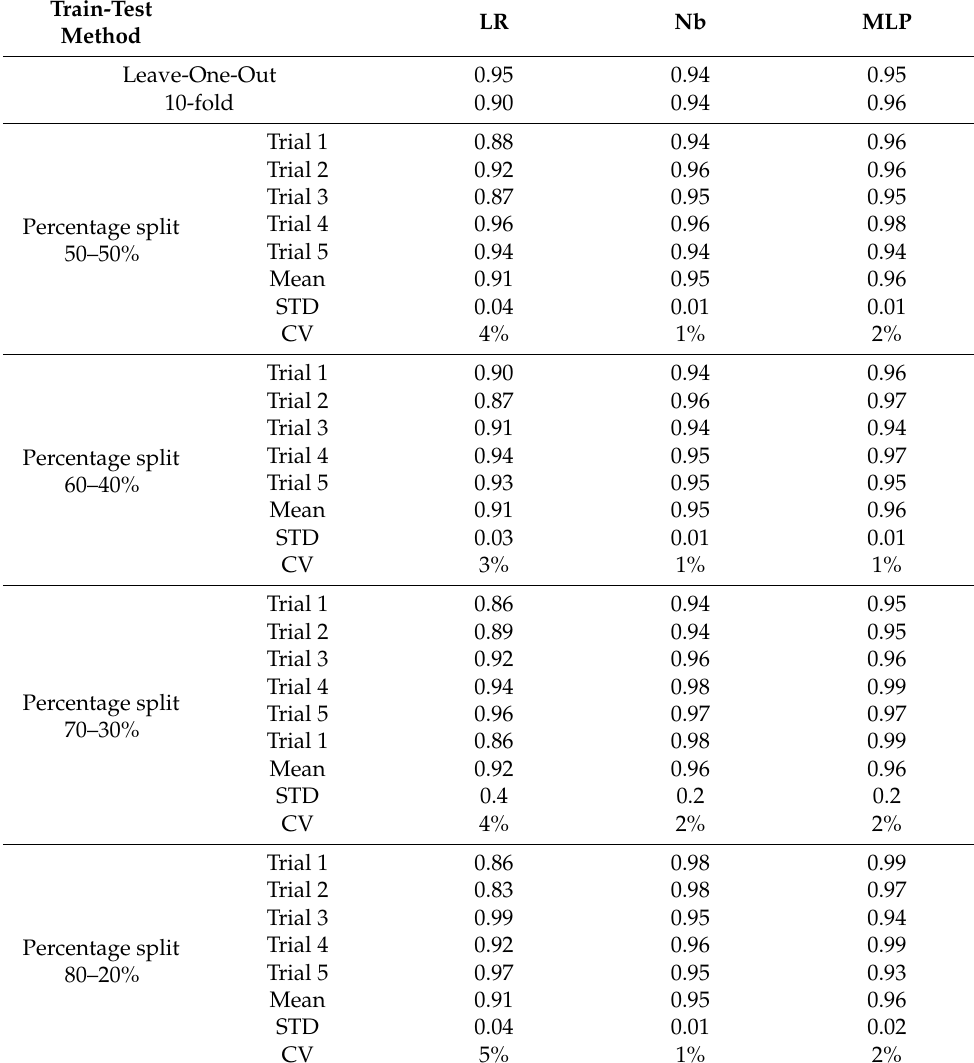
Table 3. The effect of train-test sampling on the diagnostic performance (AUC) on different ML models. LR: logistic regression, Nb: naïve bayes, MLP: multilayer